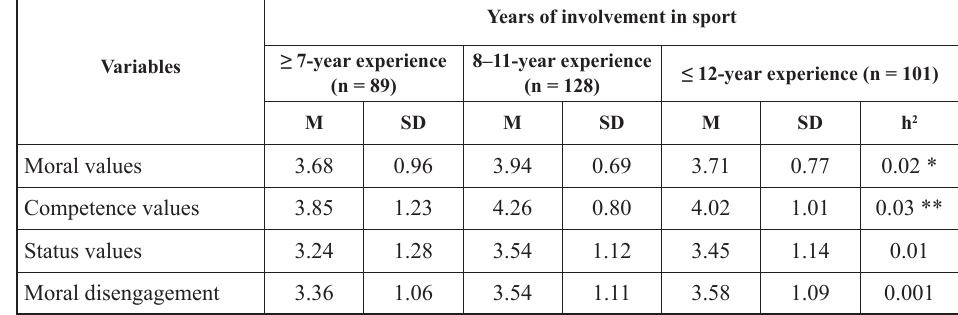
Note. ** – statistically significant difference (p < 0.01).